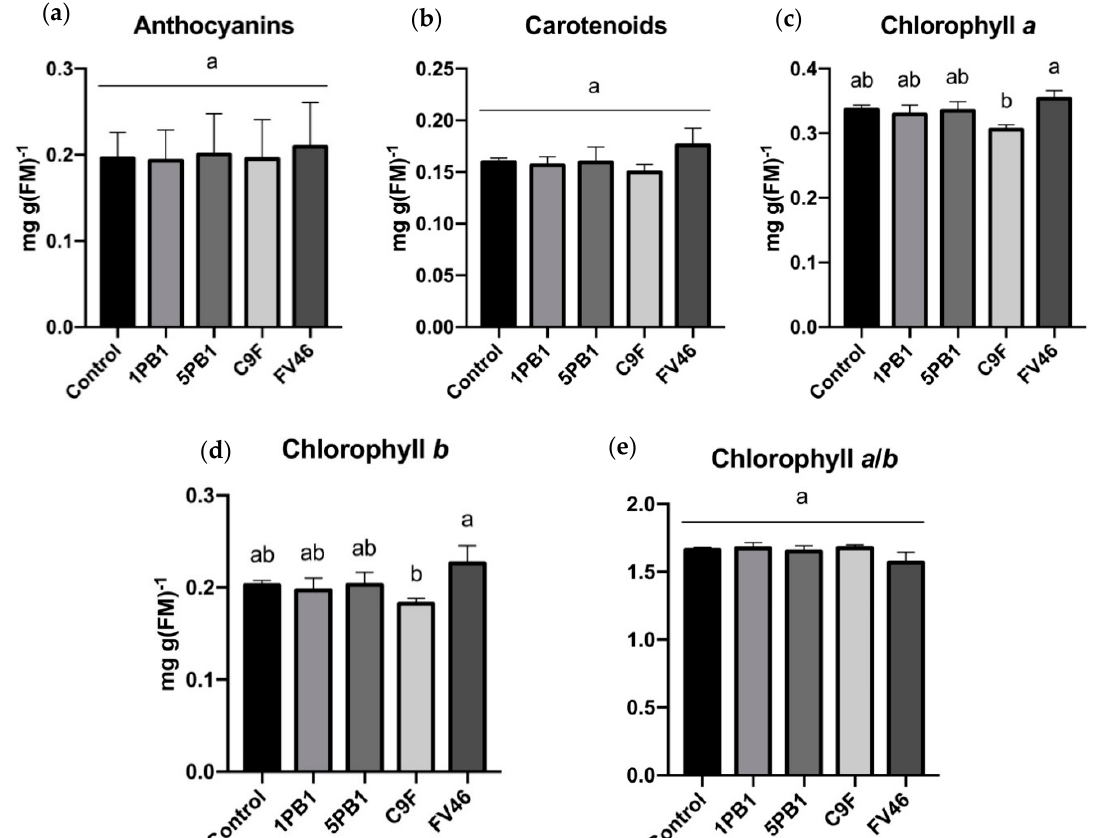
Figure 1. Effect of inoculation with isolates 1PB1, 5PB1, C9F and FV46 on tomato leaves of 130-day-old plants. ( a ) Anthocyanins, ( b ) Carotenoids; ( c ) Chl a , ( d ) Chl b , ( e ) Chl a / b . Presented values are means ± SD (n = 3) of measurements on each treatment group. Means with the same letter are not significantly different according to the Dunnett test ( p < 0.05).